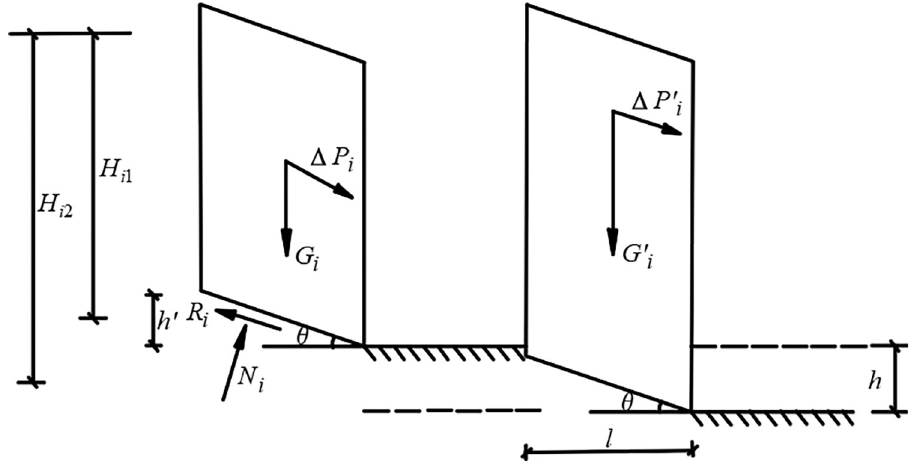
Fig 1. Force analysis of sliding